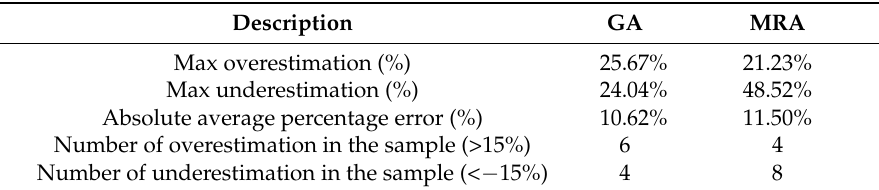
Figure 2. Fitness function value and stopping criteria generate from MATLAB software. Table 3. C omparison between GA and MRA.